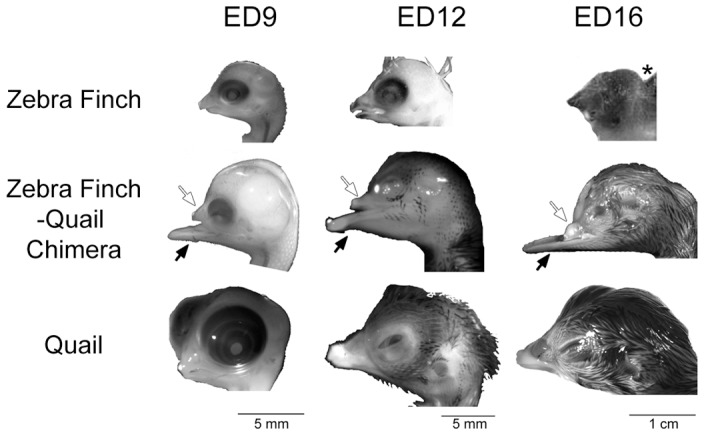
Appearance of the zebra finch, chimera, and quail embryo heads at three developmental stages.Upper row, lateral views of zebra finch embryos and post hatch day 3 animal. *: post hatch day 3 zebra finch is the age most equivalent to embryonic day 16 (ED16) quail. Middle row, zebra finch-quail forebrain chimeras. Bottom row, quail embryos. The eye, forehead, and upper beak of chimeras (white arrows) are derived from zebra finch graft during the surgery, whereas the bottom beak, hind head and necks of chimeras (black arrows) are from quail host.